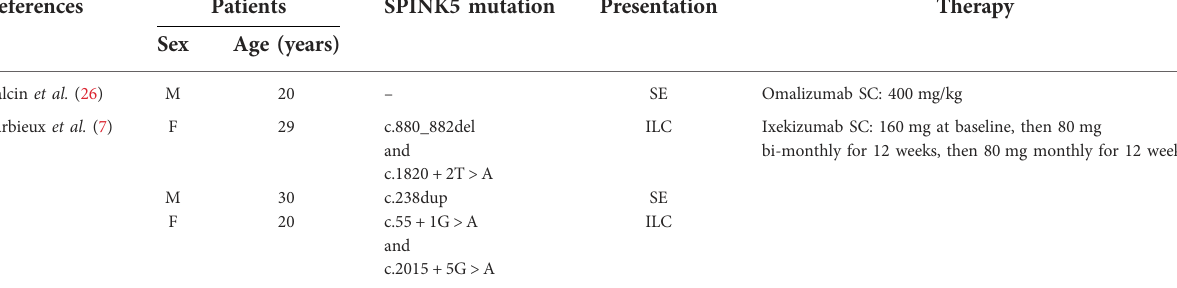
TABLE 2 Main aspects of adult case studies mentioned in the